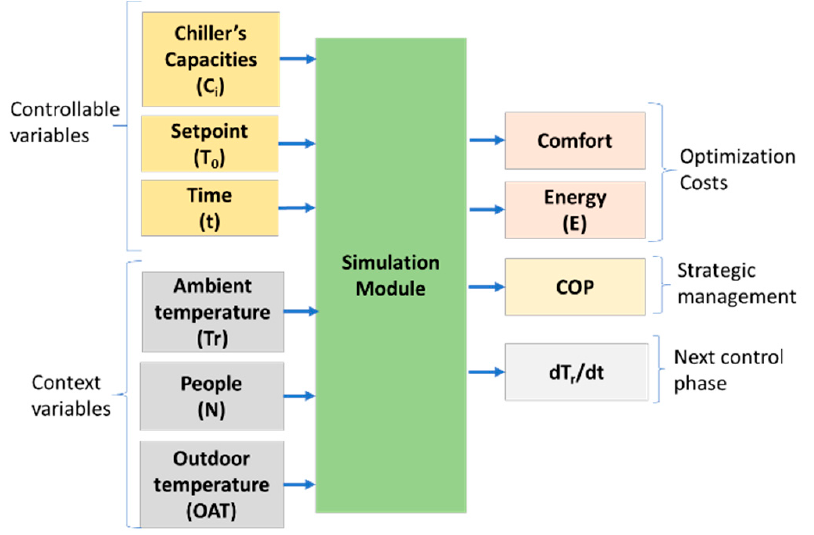
Figure 6. Simulation module’s functionality to compute the cost functions for the optimization.